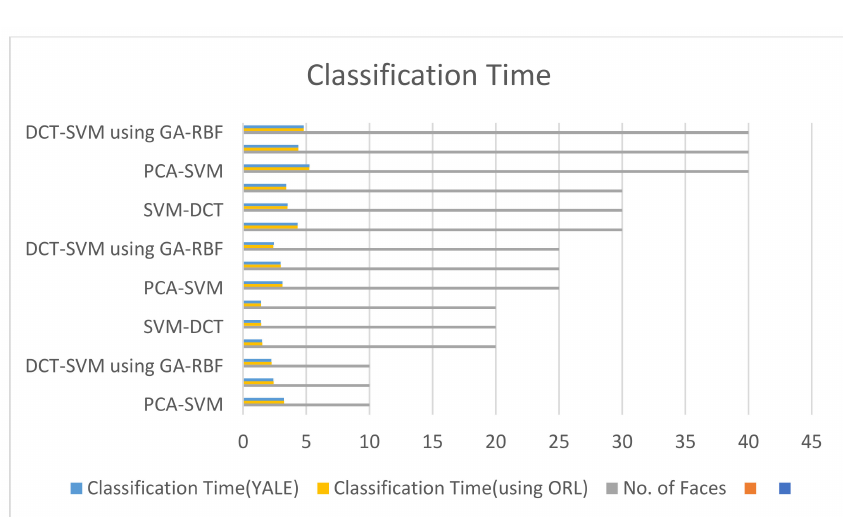
Figure 8. Training time vs. number of faces.